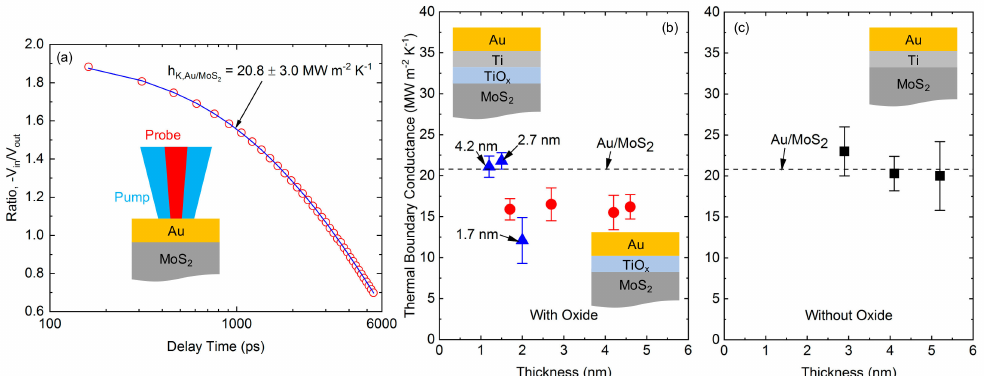
Figure 5. ( a ) TDTR data and best fit for the Au–MoS 2 structure. Thermal boundary conductance as a function of interfacial layer thickness for the MoS 2 substrates ( b ) with and ( c ) without an oxide interlayer. Samples included are Au–Ti (black squares), Au–TiO x (red circles), and Au–Ti–TiO x (blue triangles) in addition to a reference sample of Au–MoS 2 (dashed line). The arrows indicate the Ti metal thickness for each Ti–TiO x sample where data are plotted as a function of oxide thickness. Reprinted with permission from Freedy et al., Phys Rev Materials, 3, 104001 (2019), DOI: 10.1103 / PhysRevMaterials.3.104001 Copyright (2019) by the American Physical